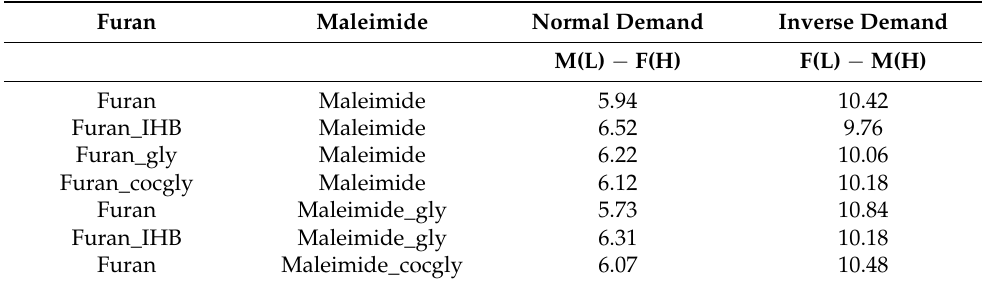
Table 2. Frontier orbital energy differences for the normal and inverse demand Diels–Alder reactions between a furan and a maleimide system. Values are given in eV.